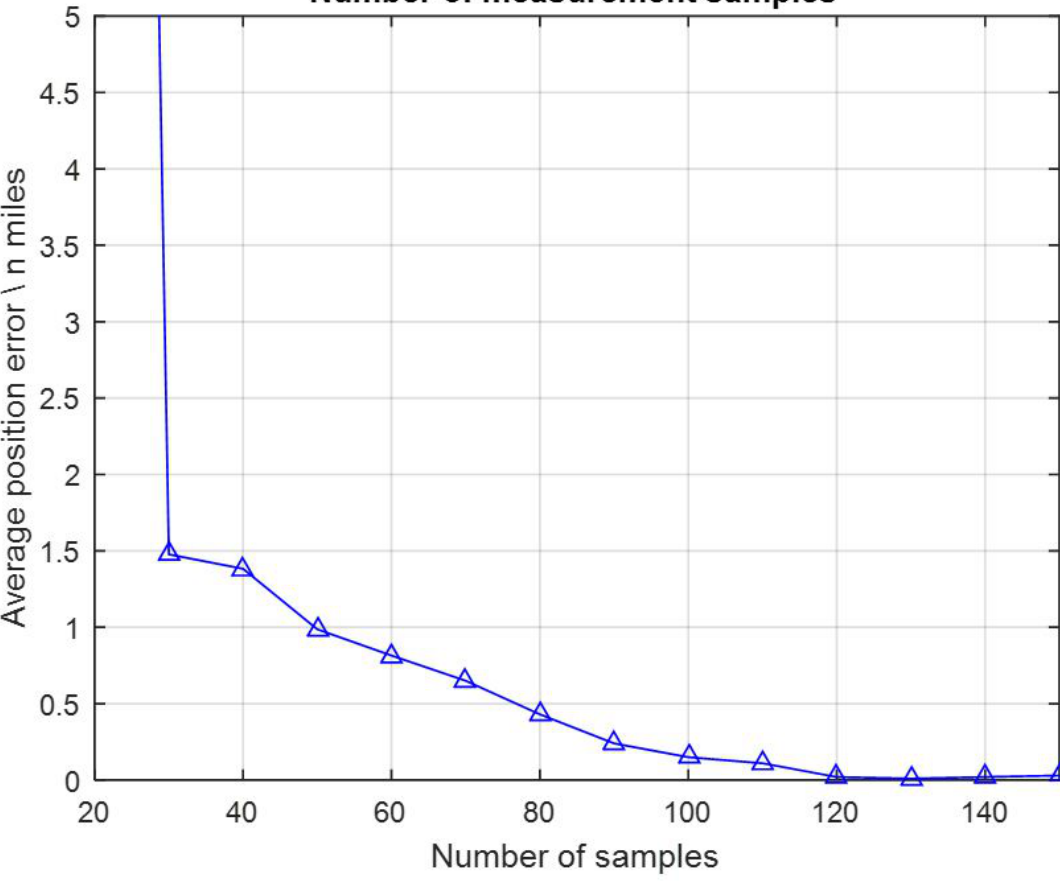
Figure 8. Average position errors with different numbers of measurement